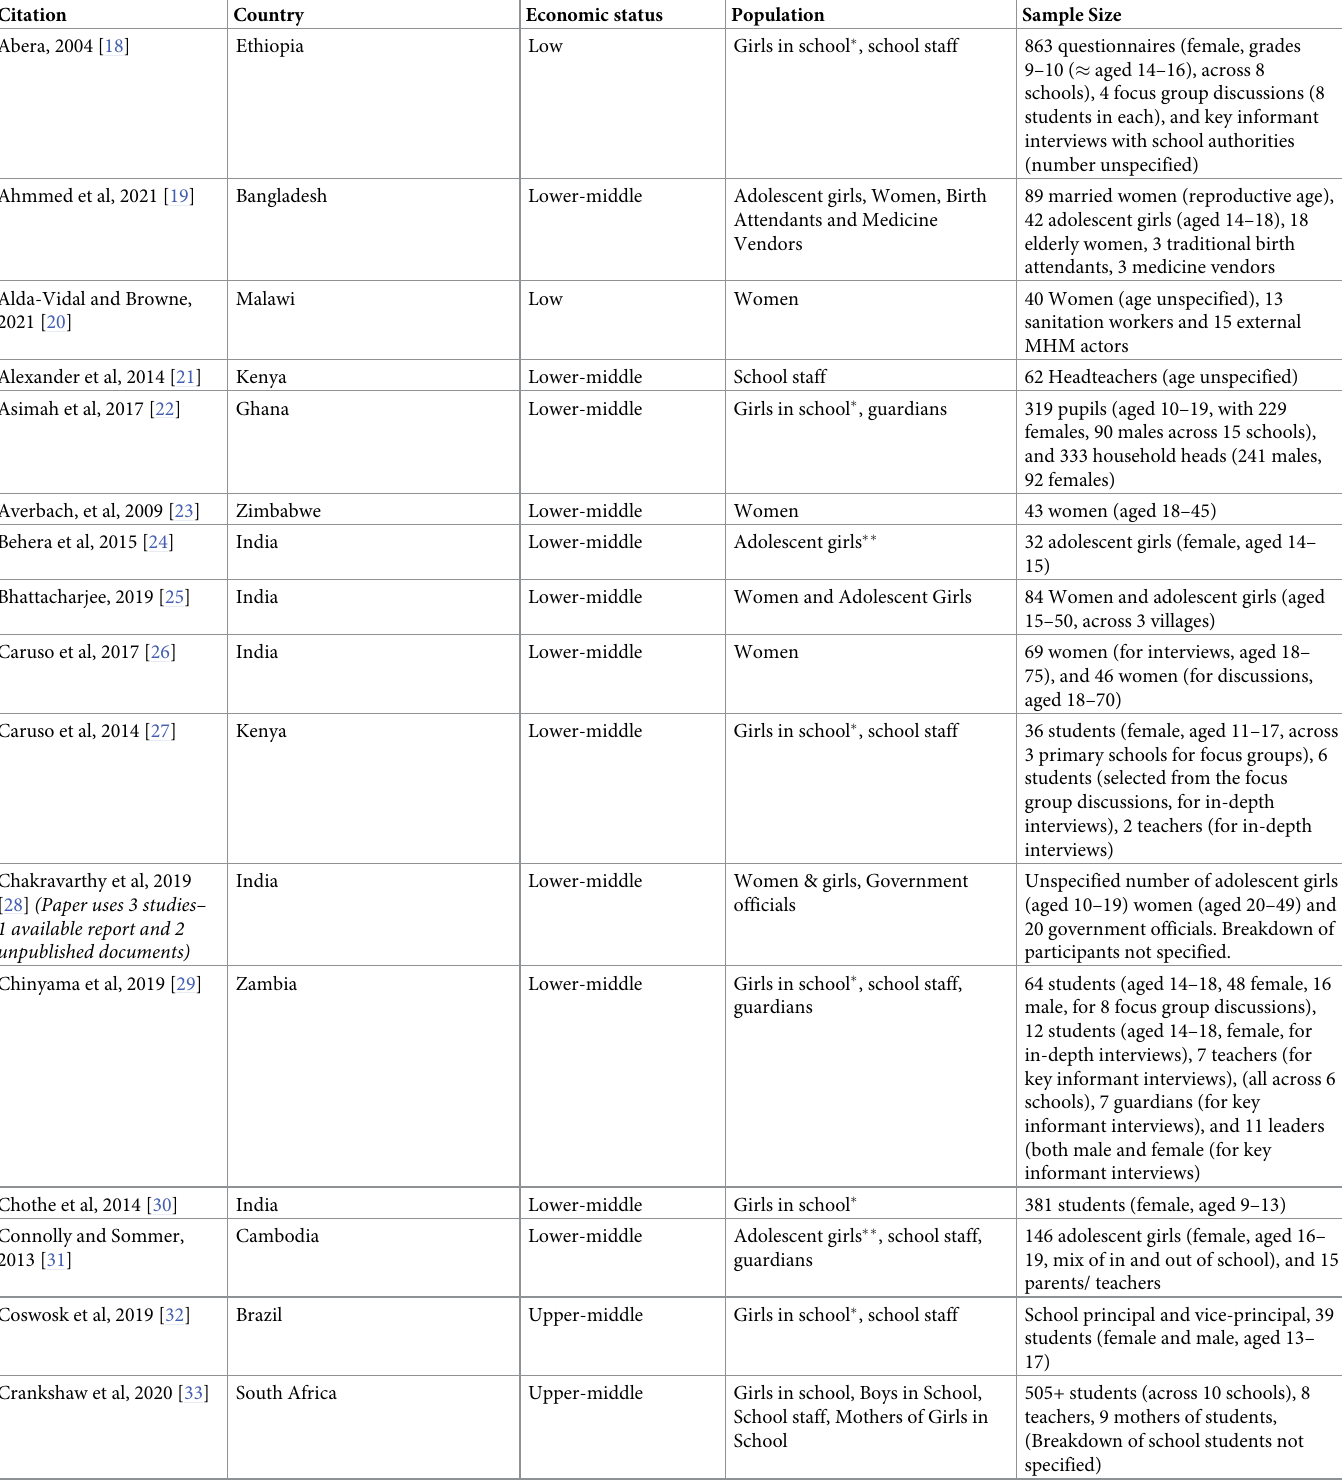
Table 2. Included